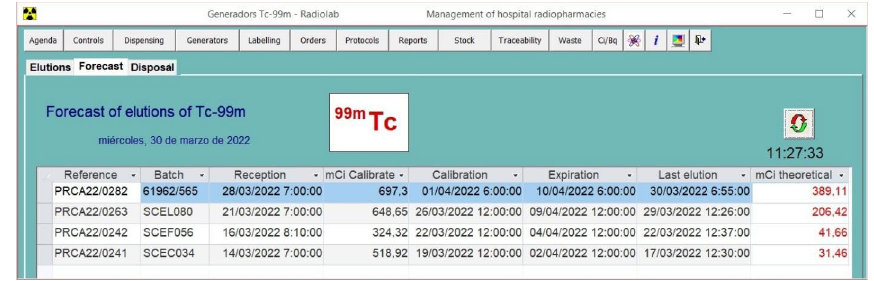
Fig. 6 Generator’s module interface: prediction of theoretical activity available on all generators in stock